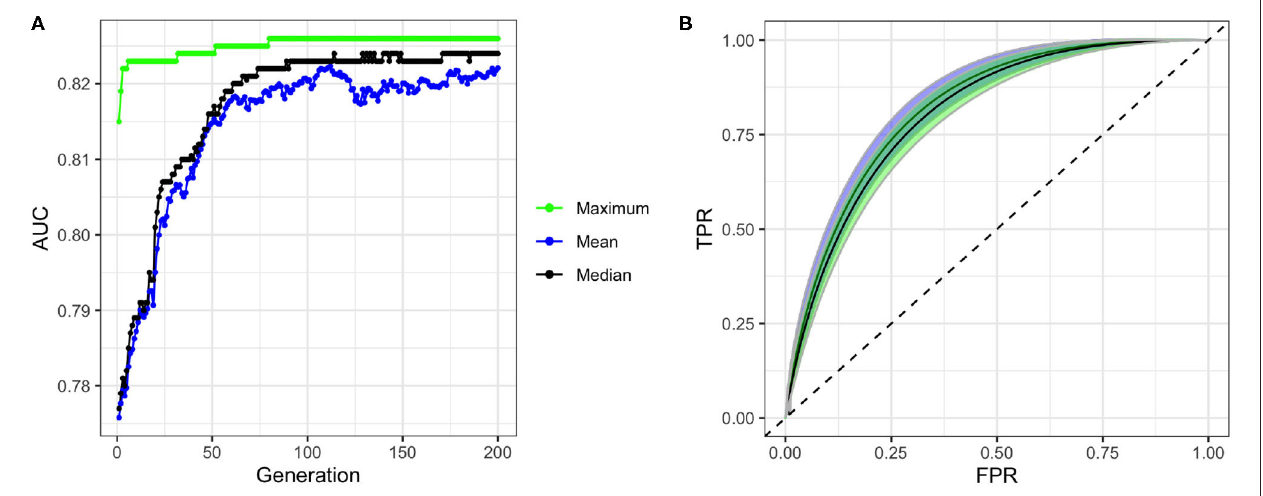
FIGURE 4 | Performance of genetic algorithm (GA) for feature selection. (A) Convergence of GA on an optimal subset of synthetic variables with maximum, mean, and median fitness values in each generation of the search. (B) ROC curves and confidence bands of optimal model predicting on validation datasets (confidence region shaded blue) and test datasets (confidence region shaded green). Dashed line represents the ROC curve of a model with no predictive ability, corresponding to an AUC of